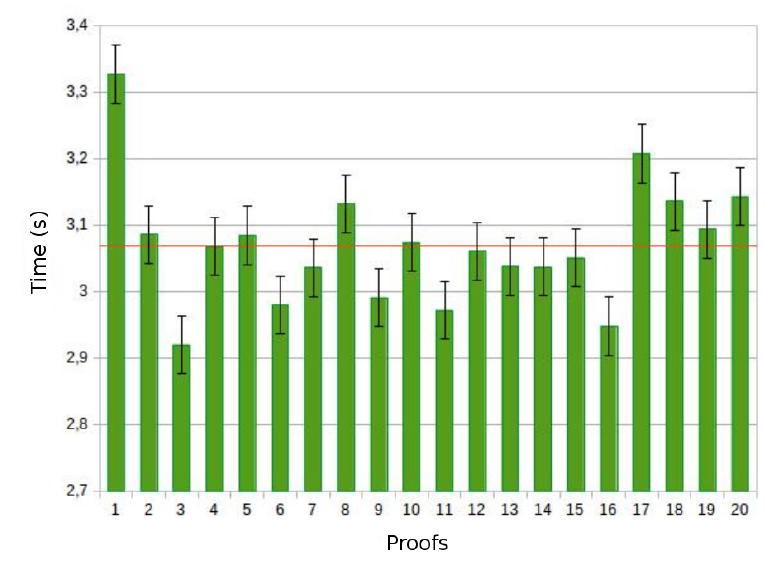
Figure 9. saveAsTextFile action for 2.5 GB file. 20 proofs average and confidence interval equal to 95%.